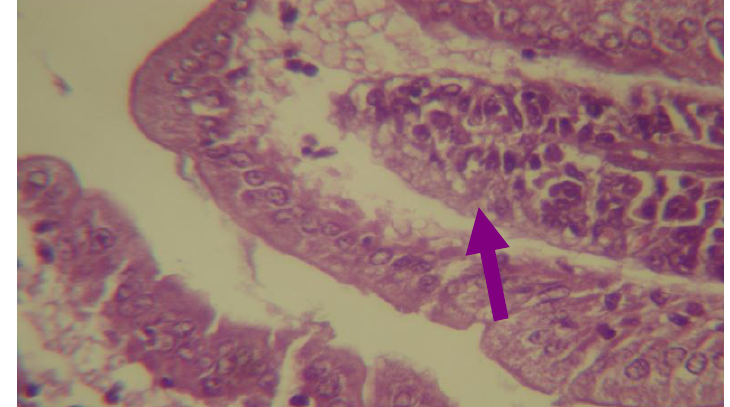
Fig (4): Histological section in intestine of mice in control positive show mononuclear cell infiltration in sub epithelial layer and goblet cell hyperplasia and erosion of epithelial lining of villi ← (H&E 40 X).